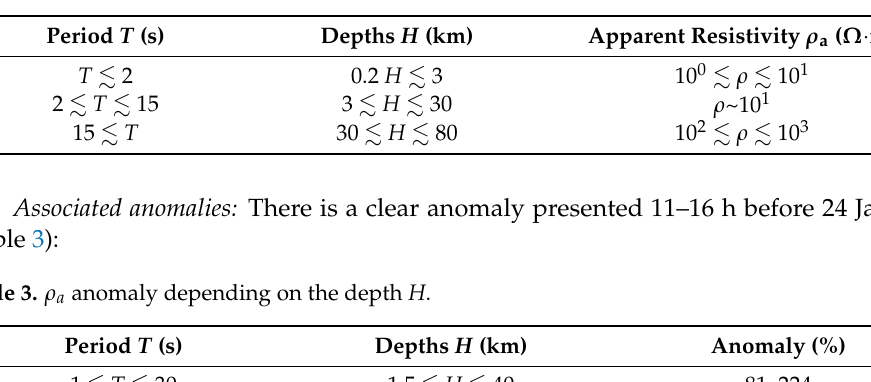
Table 2. Variations of the ρ a depending on the depth H .